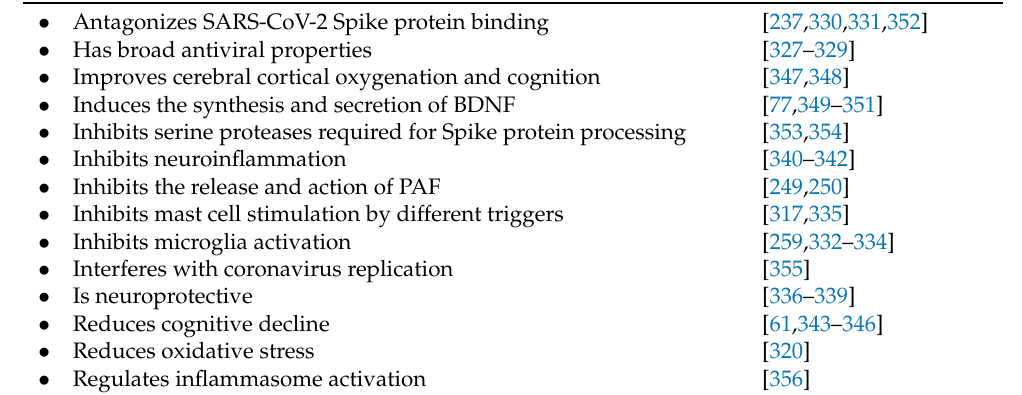
Table 5. Beneficial Actions of Luteolin